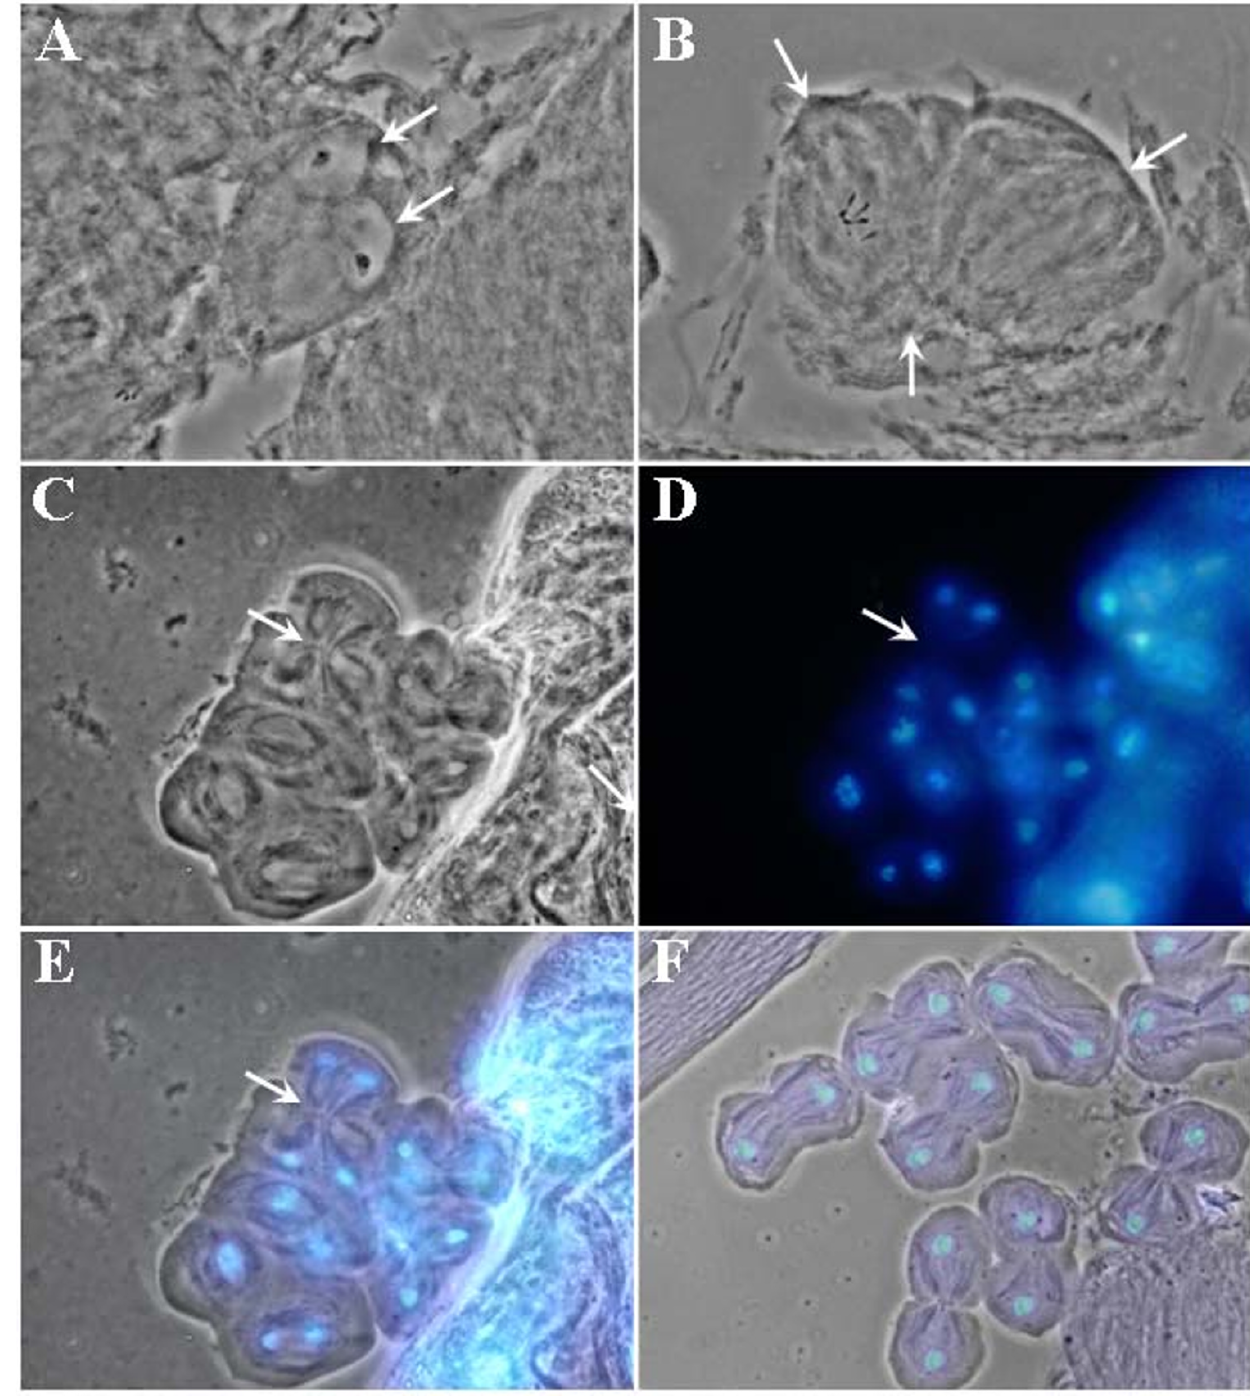
Figure 3 Abnormalities observed during meiosis of Mer 3 spermatocytes: a spermatid containing two nuclei of equal size (arrows) and two Nebenkerns (A), tripolar spindle in a spermatocyte going through the second meiotic division (B), and four-polar spindle in a spermatocyte undergoing the second meiotic division (C-E). Panel C shows the phase contrast image, panel D the DAPI- stained nuclei, and panel E the merged image. Arrow points to the central spindle midzone [29]. For comparison, wild-type meiotic cells in telophase were shown